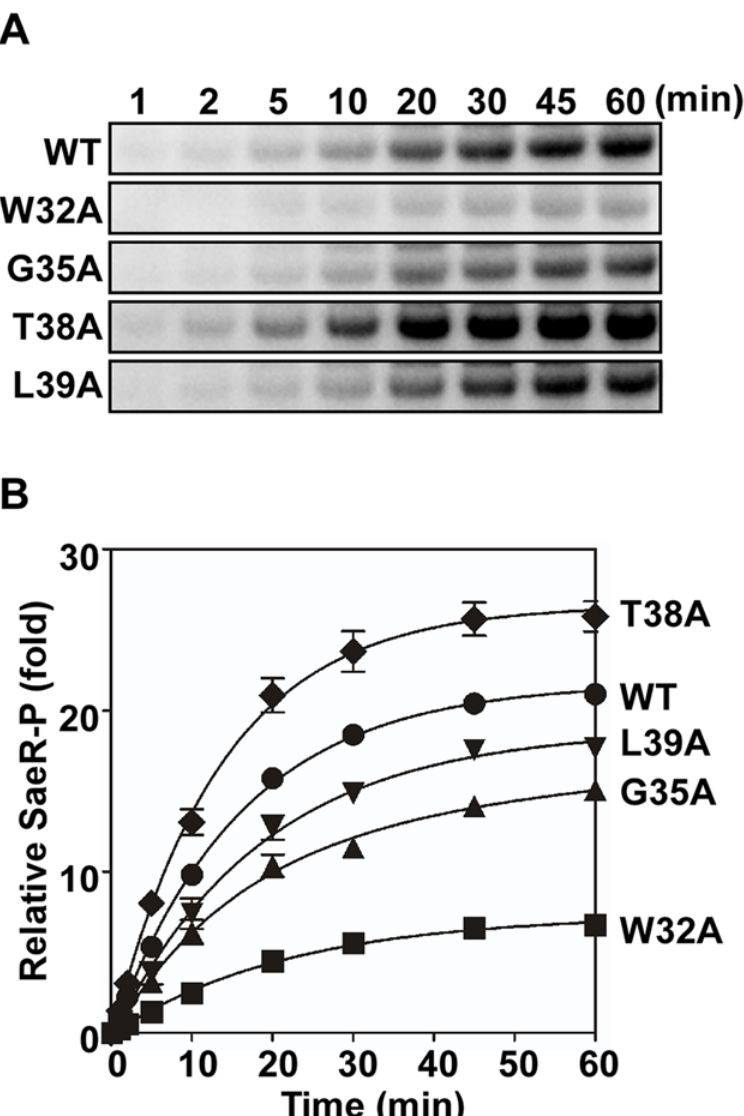
Fig 6. Membrane vesicles harboring the linker peptide mutant SaeS exhibit altered phosphotransferase activity. (A) Levels of SaeR-P following incubation of SaeR, [ γ - 32 P] ATP, and membrane vesicles (300 μ g) harboring the wild-type or the various linker mutant SaeS proteins. (B) Quantitation of the phosphotransfer assay shown in (A). Each datum of the plot depicts the level of SaeR-P relative to that by the wild-type SaeS at the initial time (1 min). Data correspond to the mean values of three independent experiments, and error bars show standard